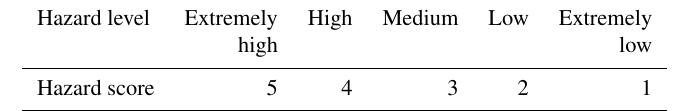
Table 8. Hazard level and score (Lin, 2017).